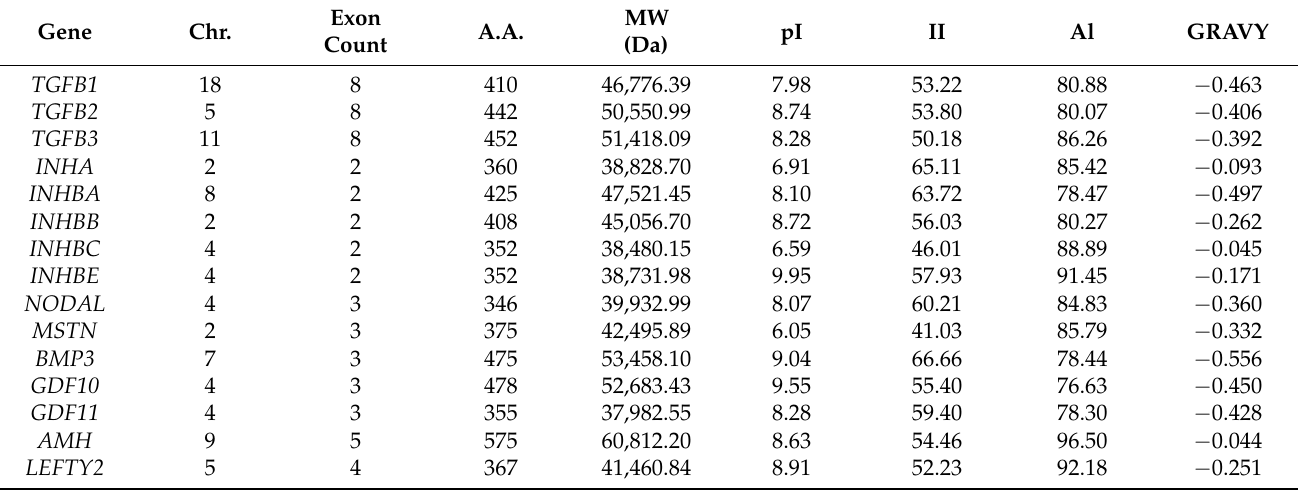
Table 2. Physicochemical properties of the TGF-like genes of the buffalo TGF- β gene